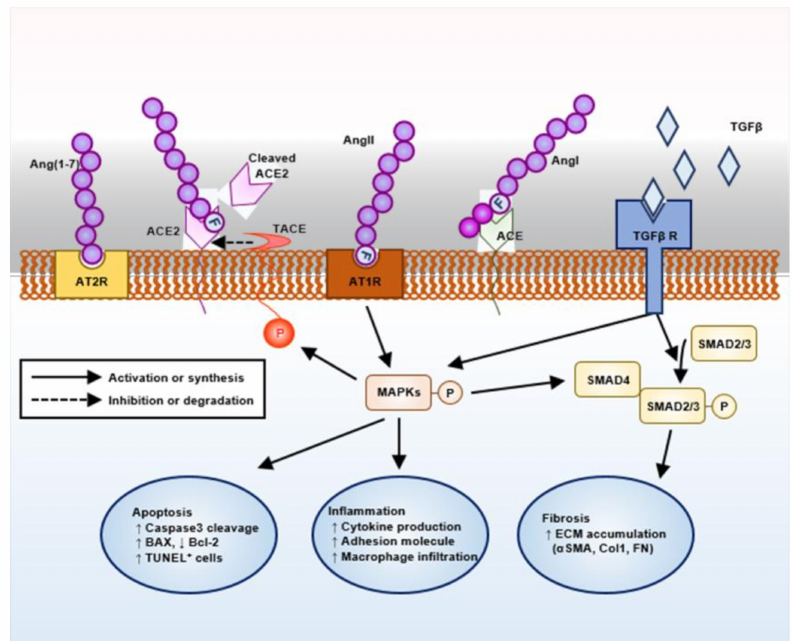
Figure 1. Schematic overview on the intra-renal renin–angiotensin system (RAS) machinery and its potential action